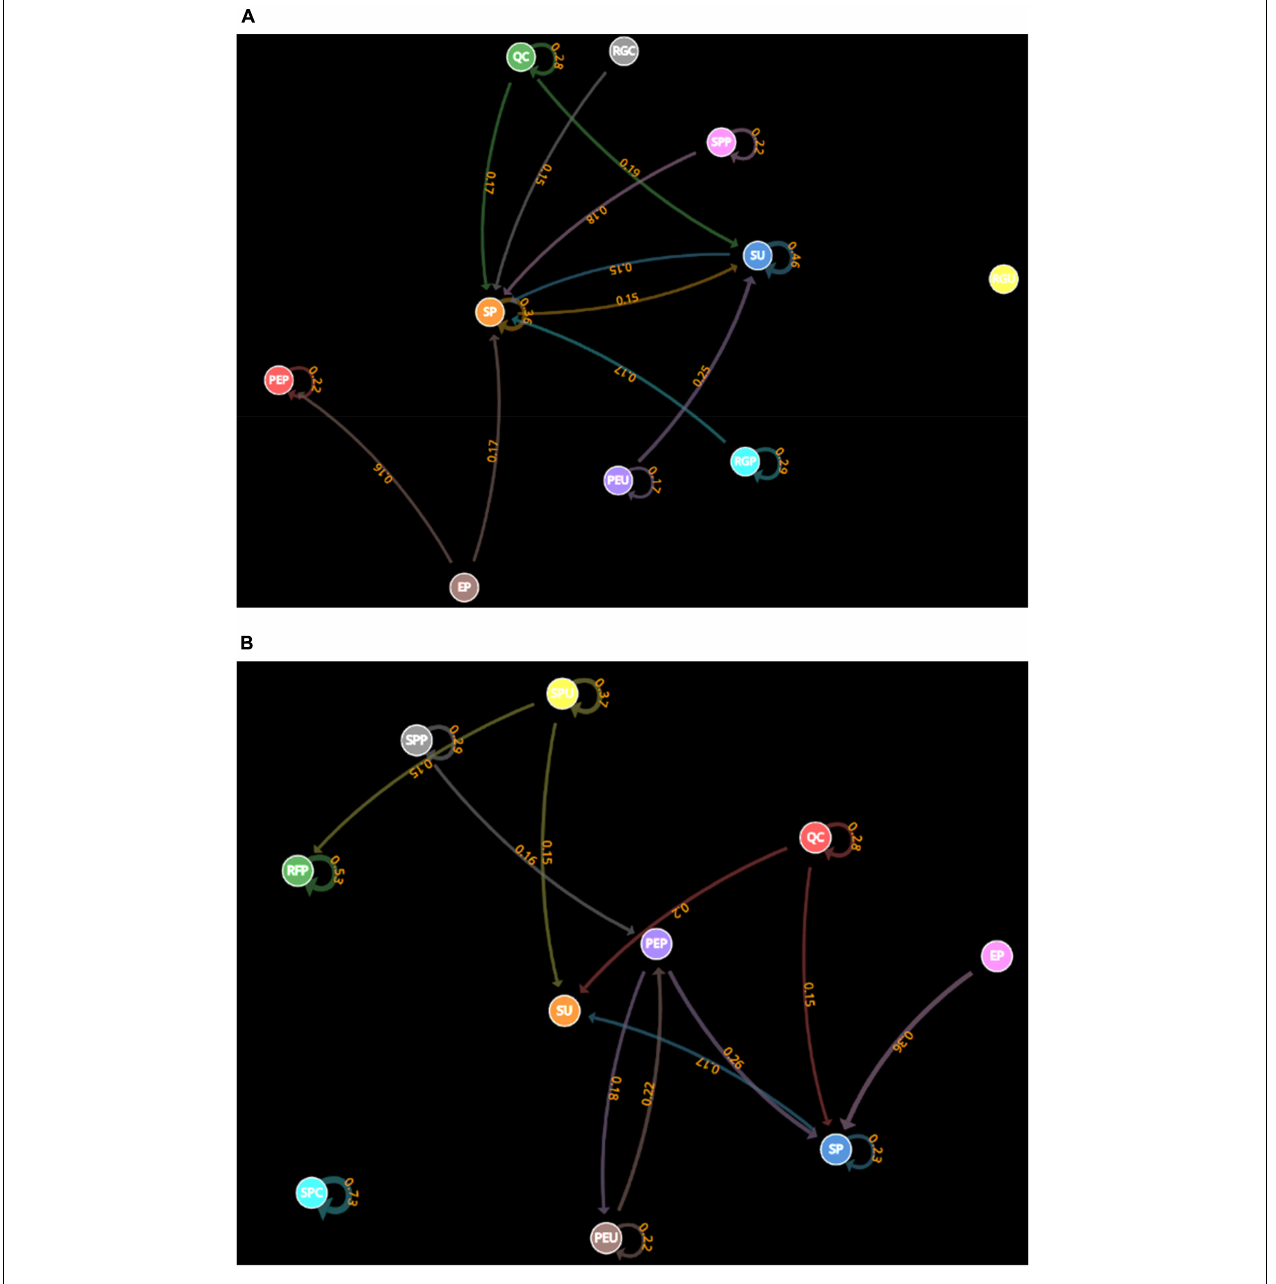
FIGURE 9 | Markov Chain analysis results of the 10 most occurring states. (A) Discourse sessions. (B) Metadiscourse sessions. SP, simple claim/appraisal or information and positive; SU, simple claim/appraisal or information and unidentifiable; RFP, reflection and positive; QU, question and curiosity; PEP, partial explanation or integration and positive; PEU, partial explanation or integration and unidentifiable; EP, elaborated explanation or integration and positive; SPP, student proposal and positive; SPU, student proposal and unidentifiable; SPC, student proposal and curiosity; RGC, regulation and curiosity; RGU, regulation and unidentifiable; RGP, regulation and